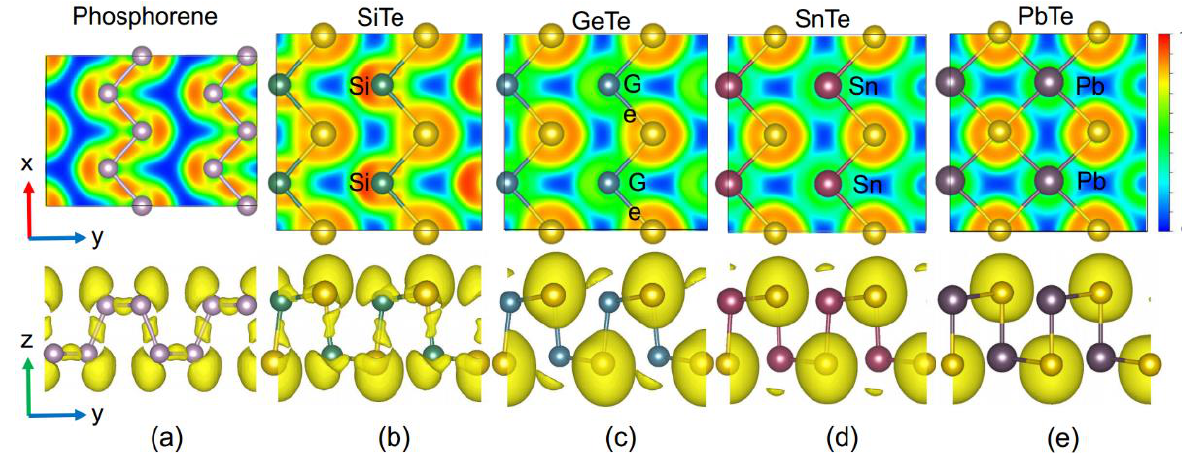
Figure 4. ELF maps sliced across the Te layers (top panel) and side views of the ELF with isosurface value 0.64 (bottom panel) for the monolayer ( a ) SiTe, ( b ) GeTe, ( c ) SnTe, and ( d ) PbTe. Increasing electron localization from 0 to 1 is plotted with colors from blue to red.